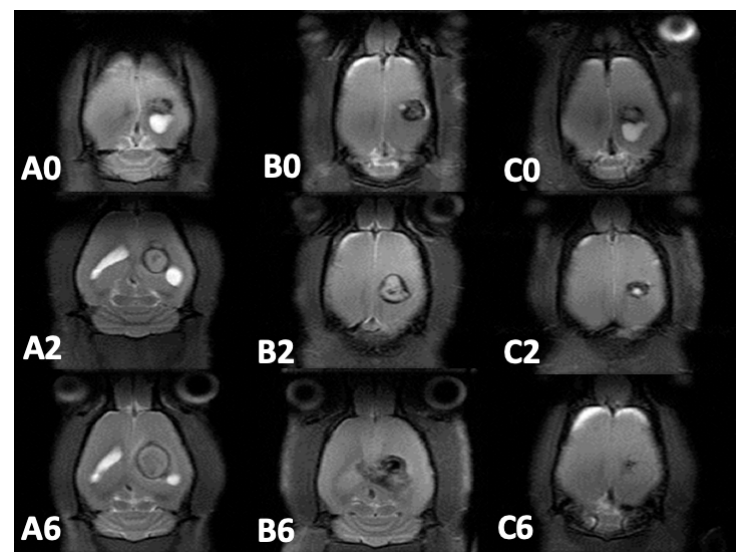
Figure 7. Serial magnetic resonance imaging. The number in the lower left-hand corner of each image indicates the number of weeks after di ff erent treatments. No significant di ff erences among pretreatment brain abscesses in groups A (A0), B (B0), and C (C0) were observed. The abscesses in groups A and B enlarged progressively with obvious mass e ff ect. Bilateral ventricle involvement was noted in group A (A2 and A6). The abscess volume increased and grew inwardly (B2) then crossed the midline (B6). The abscess volume decreased progressively in group C after injection of vancomycin-embedded poly(lactide- co -glycolide acid) microparticles (C2 and C6), and no perifocal edema was observed. (x 0.8).